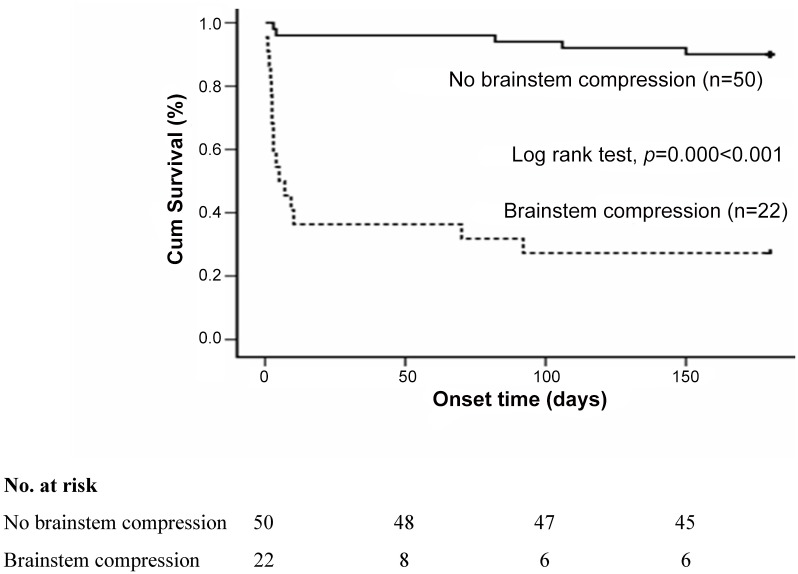
Kaplan-Meier survival analysis for rate of six-month mortality.